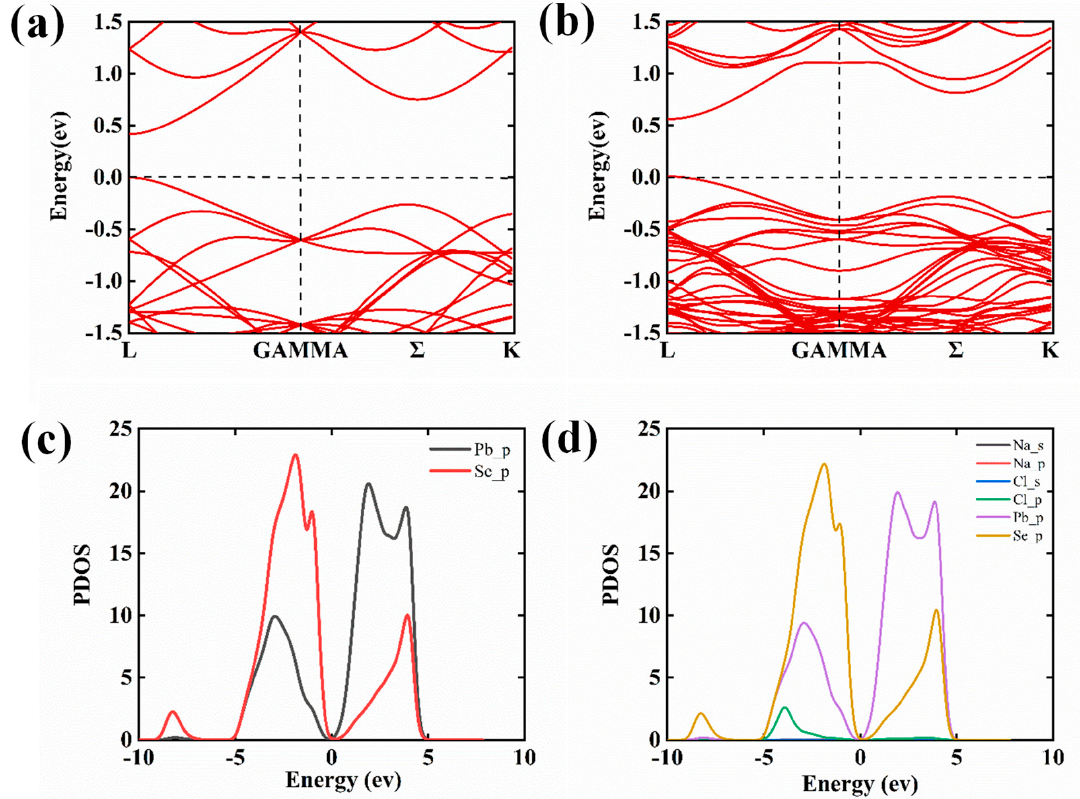
Figure 4. Band structure of pure PbSe with ∆ Ev~0.28 eV ( a ); NaCl-doped PbSe with ∆ Ev~0.18 eV ( b ); the corresponding DOS for pure PbSe ( c ) and PbSe with NaCl doping ( d ), where the corresponding states are presented in a clear manner to demonstrate their respective contributions.